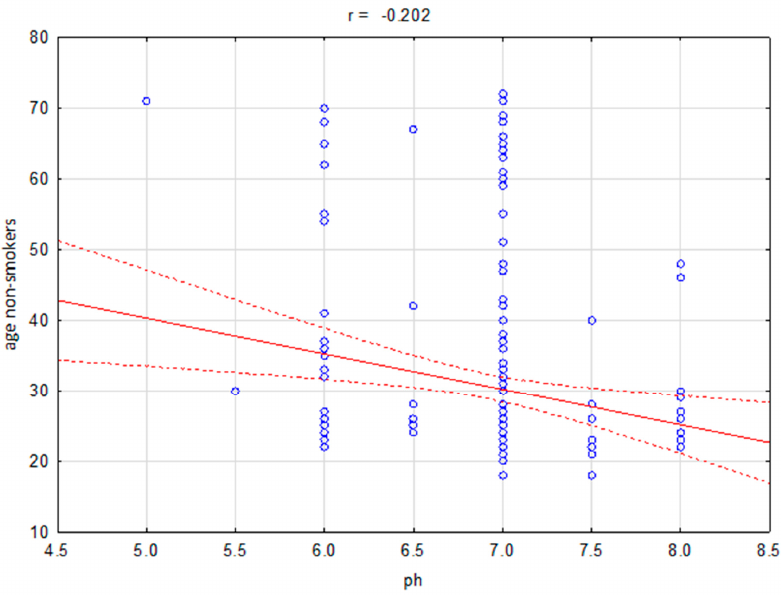
Figure 1. Correlation between age and pH for the non-smokers group (r = − 0.202, p = 0.004).